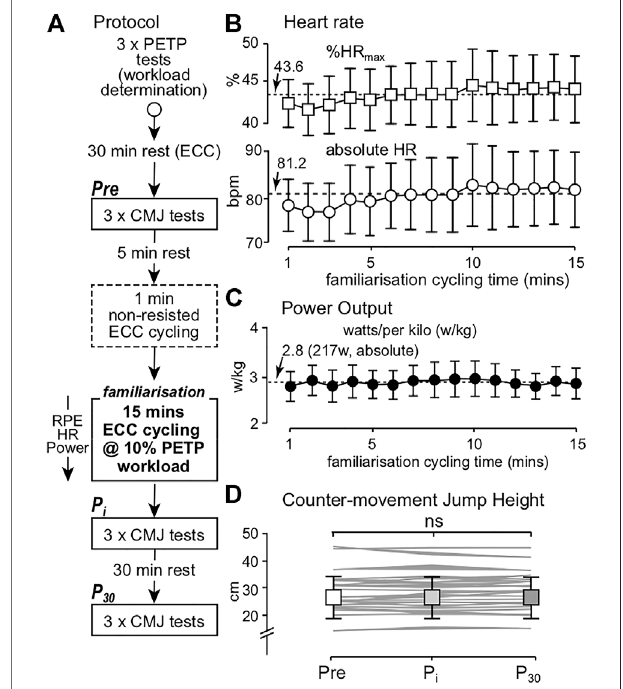
FIGURE 1 | (A) Experimental protocol; (B) group mean (±95% CI, n = 22) %HR max (squares) and absolute HR (bpm, circles) values; (C) group mean (±95% CI) relative power output recorded from 21 participants (due to the power fi le of one participant not saving post ECC cycling); (D) group mean (±SD) and individual mean (greyscale lines) CMJ height values recorded pre- (Pre), immediately post (P i ) and 30-min post (P 30 ) ECC cycling. Broken lines represent the overall mean %HR max , absolute HR and relative power output recorded during ECC cycling. ns denotes no signi fi cant